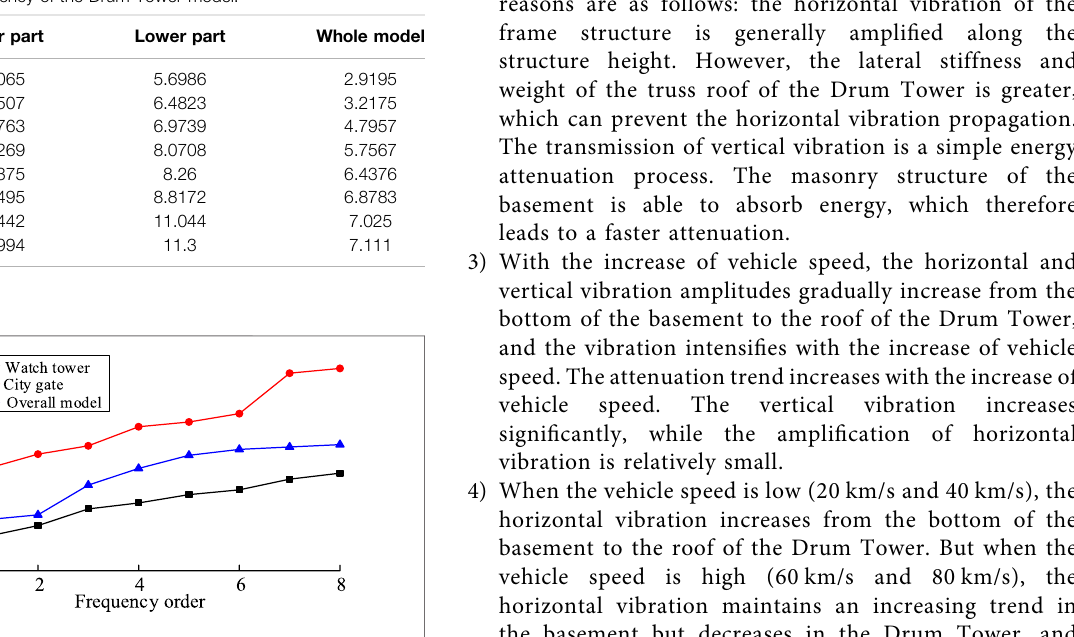
FIGURE 4 | Variation trend of the natural frequency of the Drum Tower model.